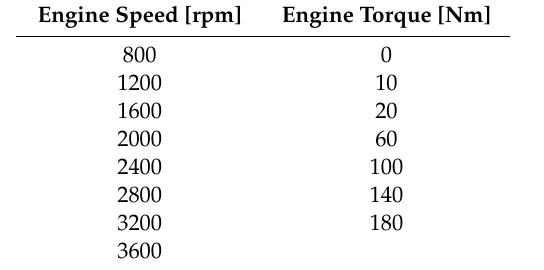
Table 3. Operating point levels for the development of the soot model.